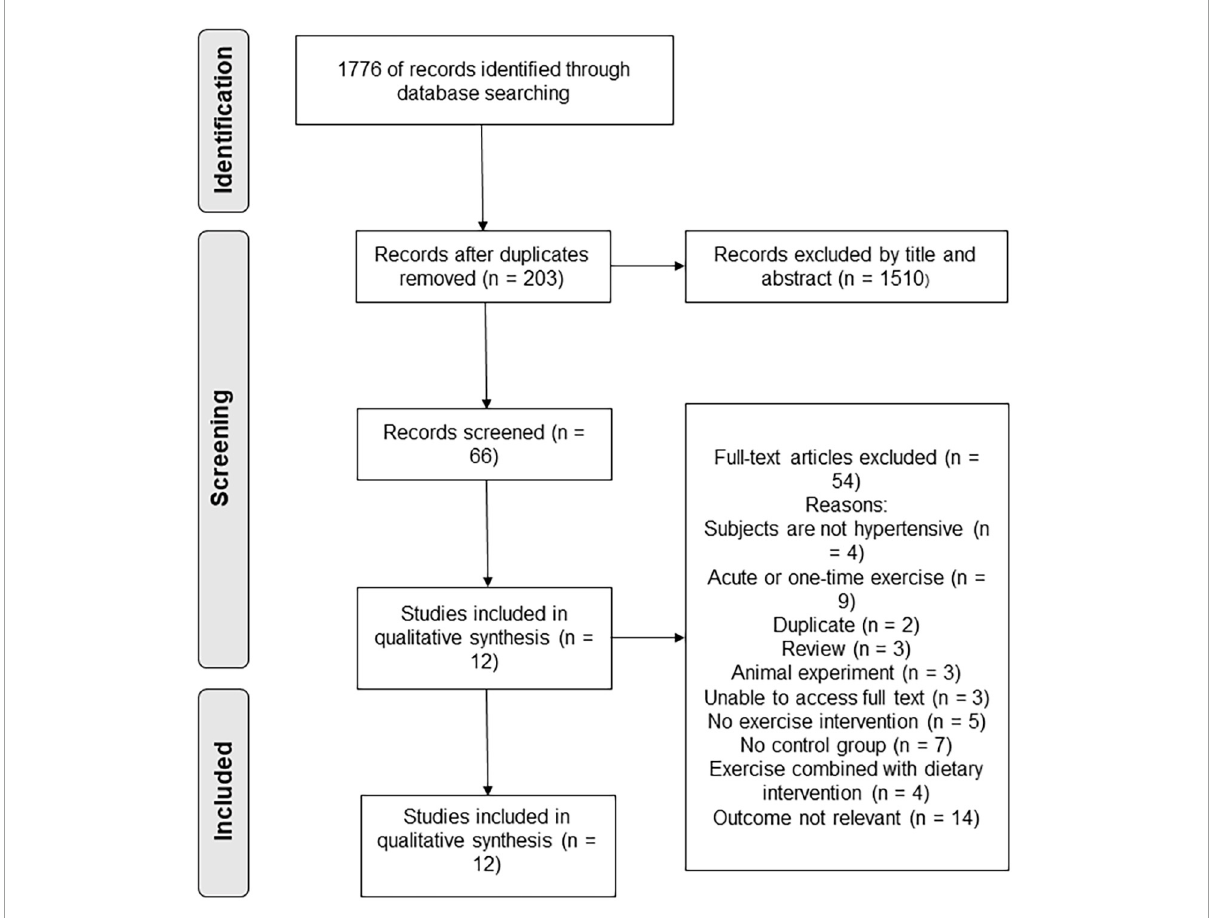
FIGURE1 Flowchart of the literature-retrieval